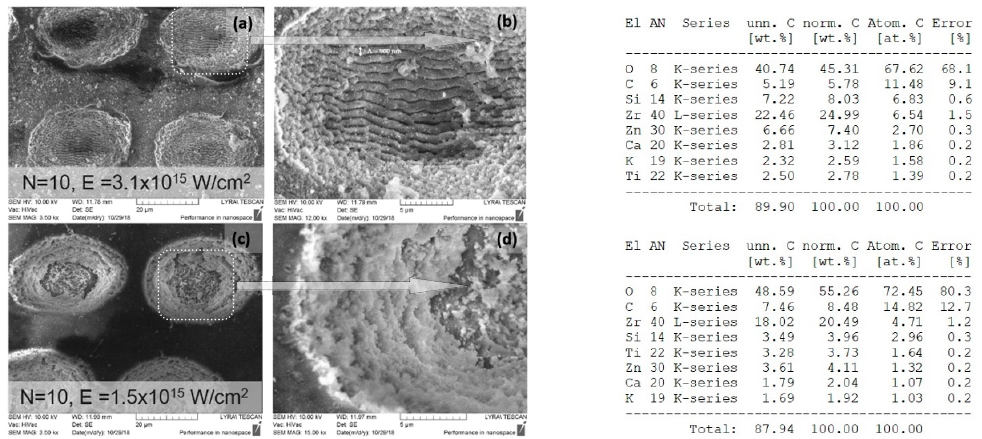
Figure 7. SEM images showing structures formed in 70/30% Ch/Hap + 1% ZrO 2 due to irradiation with N = 10 at two laser intensities ( a ) I = 3.1 × 10 15 W/cm 2 ( c ) I = 1.5 × 10 15 W /cm 2 ; ( b ) and ( d )—magnified view of treated zones; table (upper right): Energy dispersive X-ray (EDX) spectra of elements obtained after laser treatment at I = 3.1 × 10 15 W/cm 2 ; table (bottom right): Energy dispersive X-ray (EDX) spectra of elements obtained after laser treatment at I = 1.5 × 10 15 W/cm 2 . When the number of laser pulses ( N ) increased to 100, removal of the whole layer was observed.